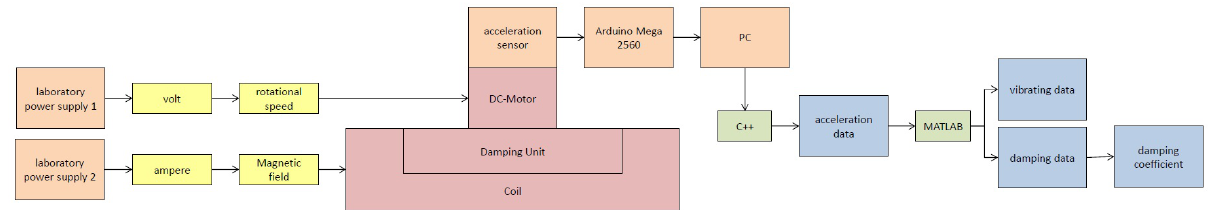
Figure 5. Workflow of the Test Setup